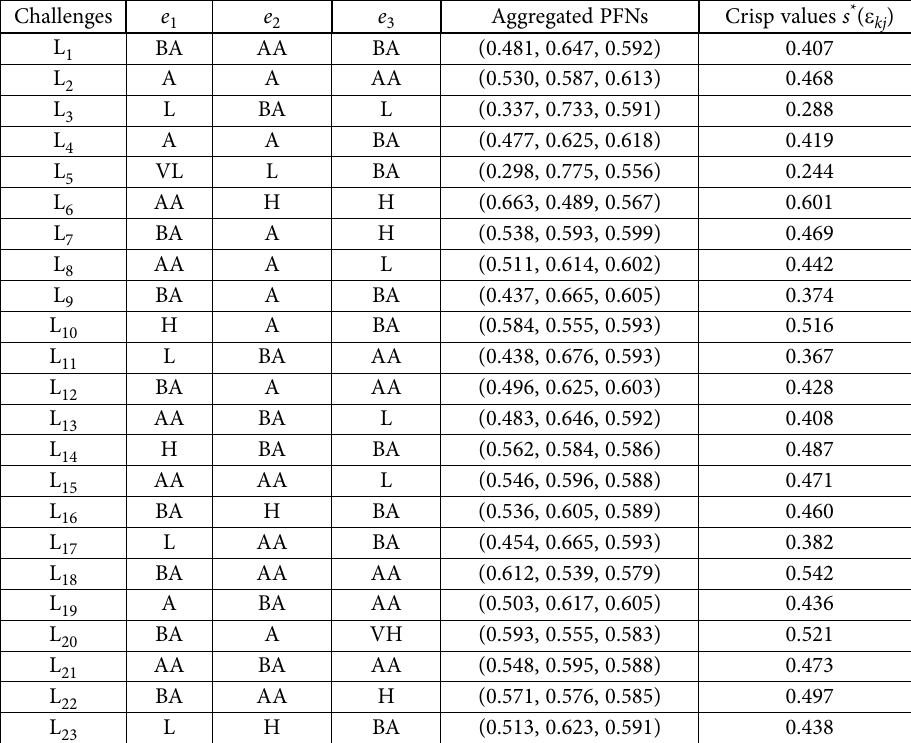
Table 7. Weights of challenges to implementing G-IoT technologies in LVs